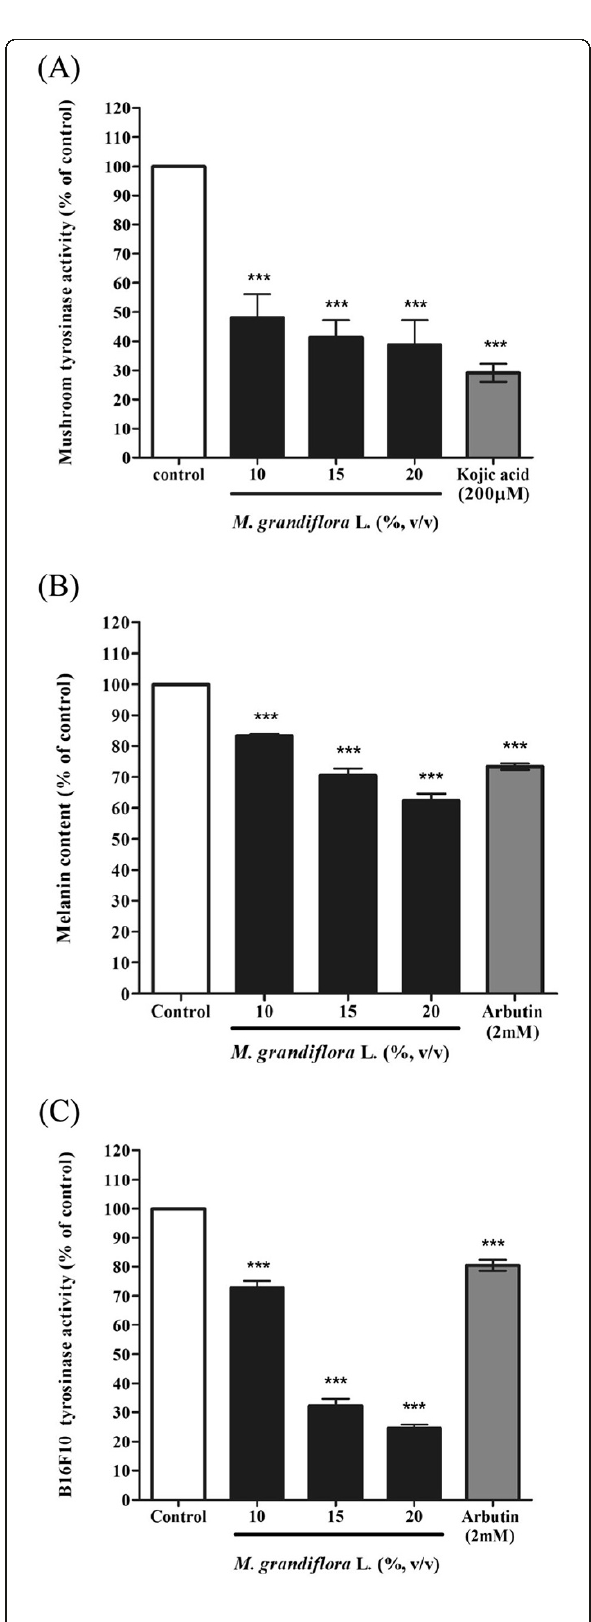
Figure 2 Inhibitory effect of M. grandiflora L. flower extract on mushroom tyrosinase activity, B16F10 melanin content and intracellular tyrosinase actvity. ( A ) Different concentrations of the flower extract (10, 15, 20%; v/v) or kojic acid (200 μ M) was incubated with the same units of mushroom tyrosinase. Following incubation, the amount of dopachrome produced was determined at 490 nm spectrophotometrically. ( B ) & ( C ) B16F10 melanoma cells were stimulated with α -MSH (100 nM) for 24 h, and then the melanin content or intracellular tyrosinase activity were measured after treatment with various concentrations of the flower extract (final concentration 10, 15, 20%; v/v) or arbutin (2.0 mM) for another 24 h. Results are represented as percentages of control, and data are presented as mean±S.D. for three separate experiments. Values are significantly different by comparison with control. *** p <